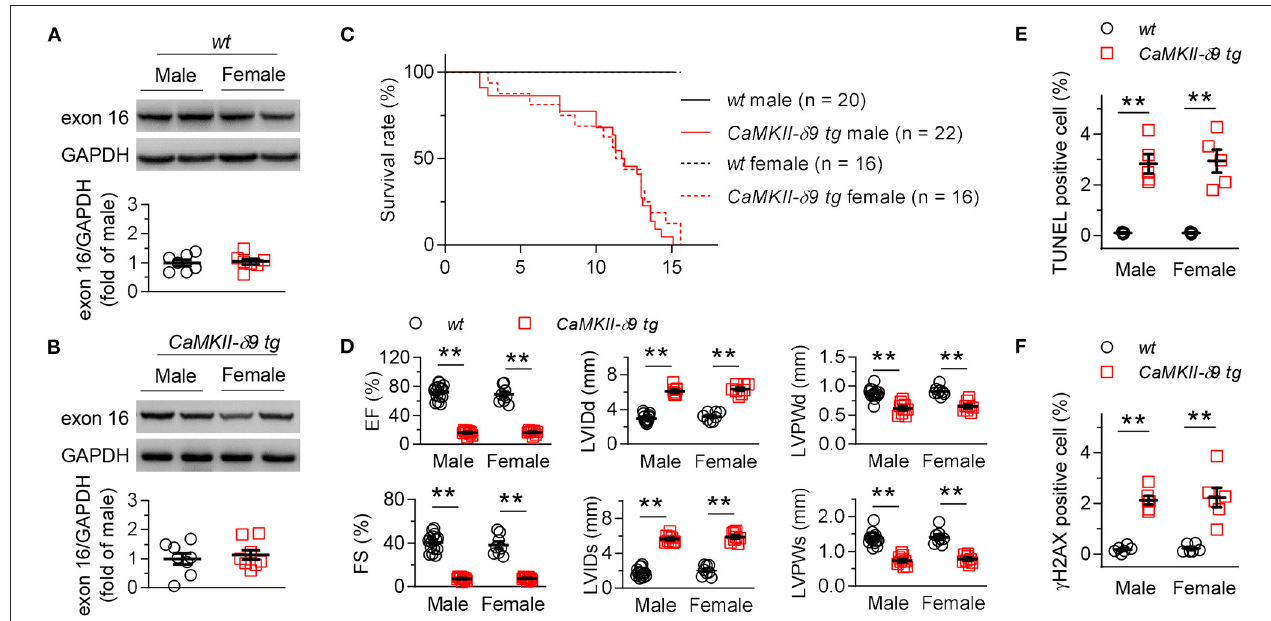
FIGURE 6 | No gender difference in the CaMKII- δ 9-induced cardiac pathology. (A,B) Representative western blots and statistical data showing the levels of CaMKII- δ 9 from the hearts of wt ( A , n = 7) and CaMKII- δ 9 tg mice ( B , n = 8). (C) Kaplan-Meier survival curves of male and female wt and CaMKII- δ 9 tg mice ( n = 20 for wt male, n = 22 for CaMKII- δ 9 tg male, n = 16 for wt female and CaMKII- δ 9 tg female). (D) Statistical data of the left ventricle echocardiography of male and female wt and CaMKII- δ 9 tg mice at 10 weeks of age ( n = 15 for wt male, n = 9 for CaMKII- δ 9 tg male, n = 8 for wt female and CaMKII- δ 9 tg female). EF, ejection fraction; FS, fractional shortening; LVIDd and LVIDs, diastolic and systolic left entricular internal diameter; LVPWd and LVPWs, diastolic and systolic left ventricular posterior wall thickness. (E,F) Statistical data of TUNEL ( E , n = 5) and γ H2AX ( F , n = 6) staining of the hearts of male and female wt and CaMKII- δ 9 tg mice at the age of 10 weeks ( n = 5). Data are mean ± S.E.M. ** P < 0.01; Student’s t -test (A,B) , log-rank (Mantel-Cox) test (C) , or two-way ANOVA (D–F)